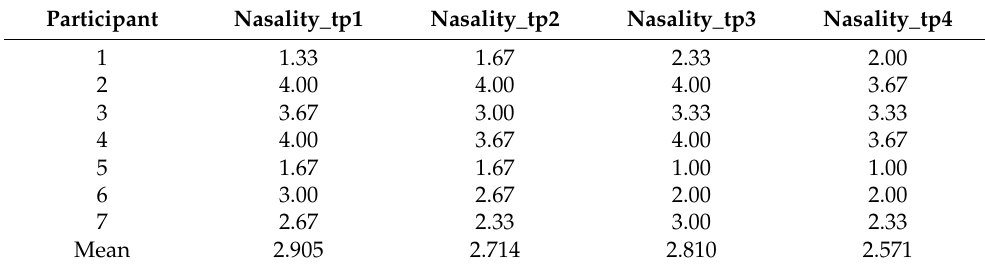
Table 18. Hypernasality level (points) individual and mean measurements at four assessment time points.